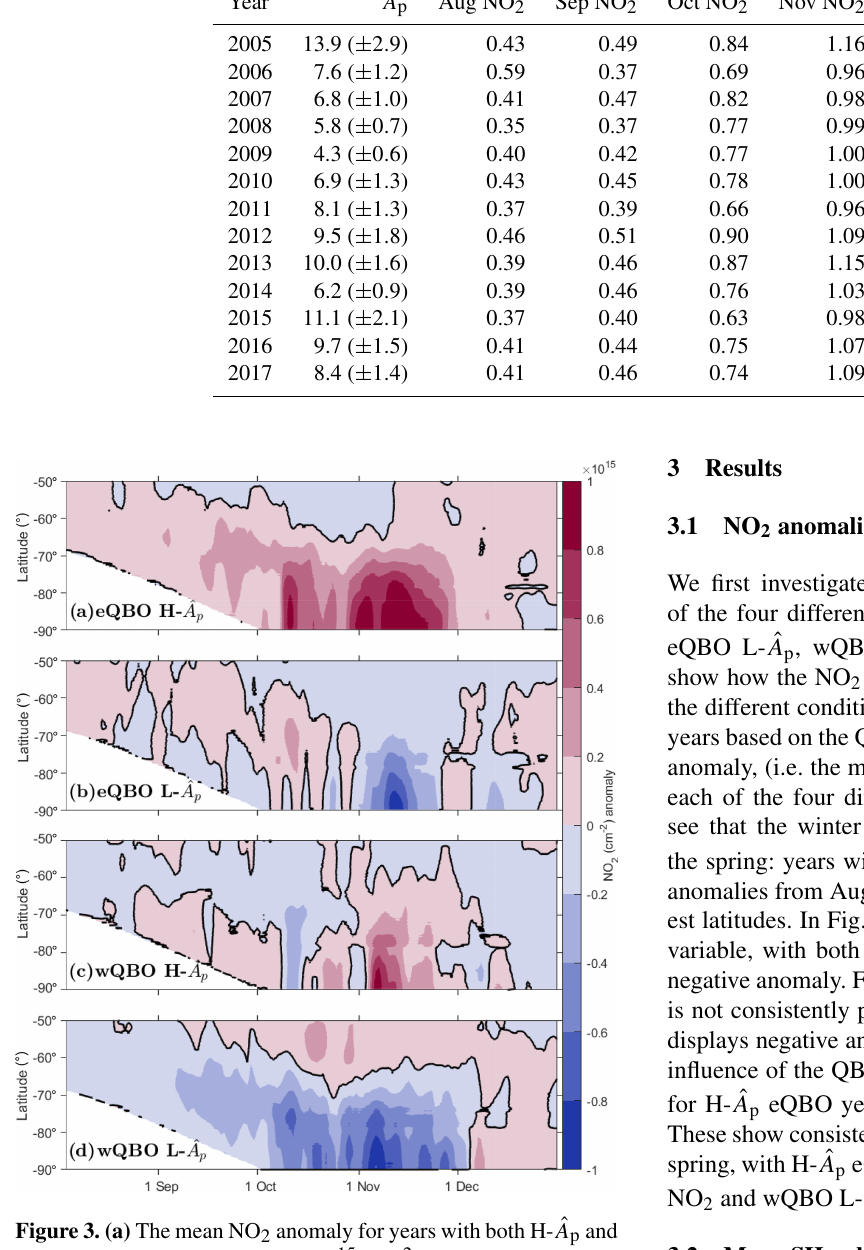
Figure 3. (a) The mean NO 2 anomaly for years with both H- ˆ A p and eQBO. The contour level is 0 . 2 × 10 15 cm − 2 with the black contour representing zero anomaly. Panels (b–d) are the same as (a) but show different combinations of ˆ A p and QBO (see